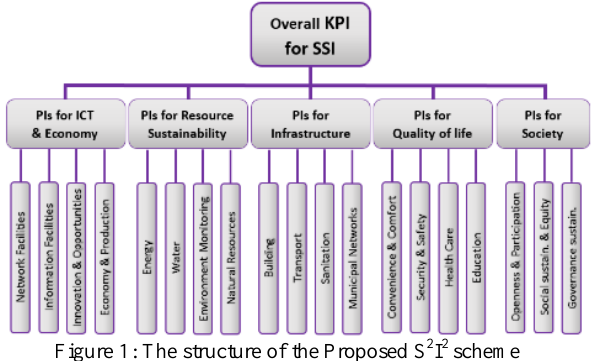
Figure 1: The structure of the Proposed S 2 I 2 scheme